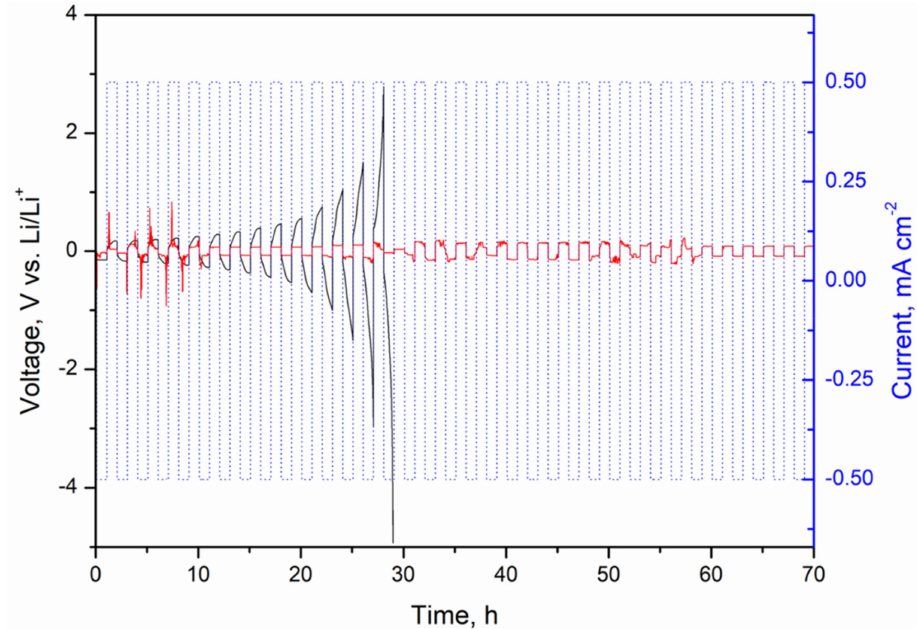
Figure 5. Voltage profile of the Li plating/stripping galvanostatic cycling at a current density of 0.5 mA cm − 2 (specific capacity: 0.5 mAh cm − 2 ) on symmetric Li|LE|Li cell (black) and Li|5 wt% NS CGPE|Li cell